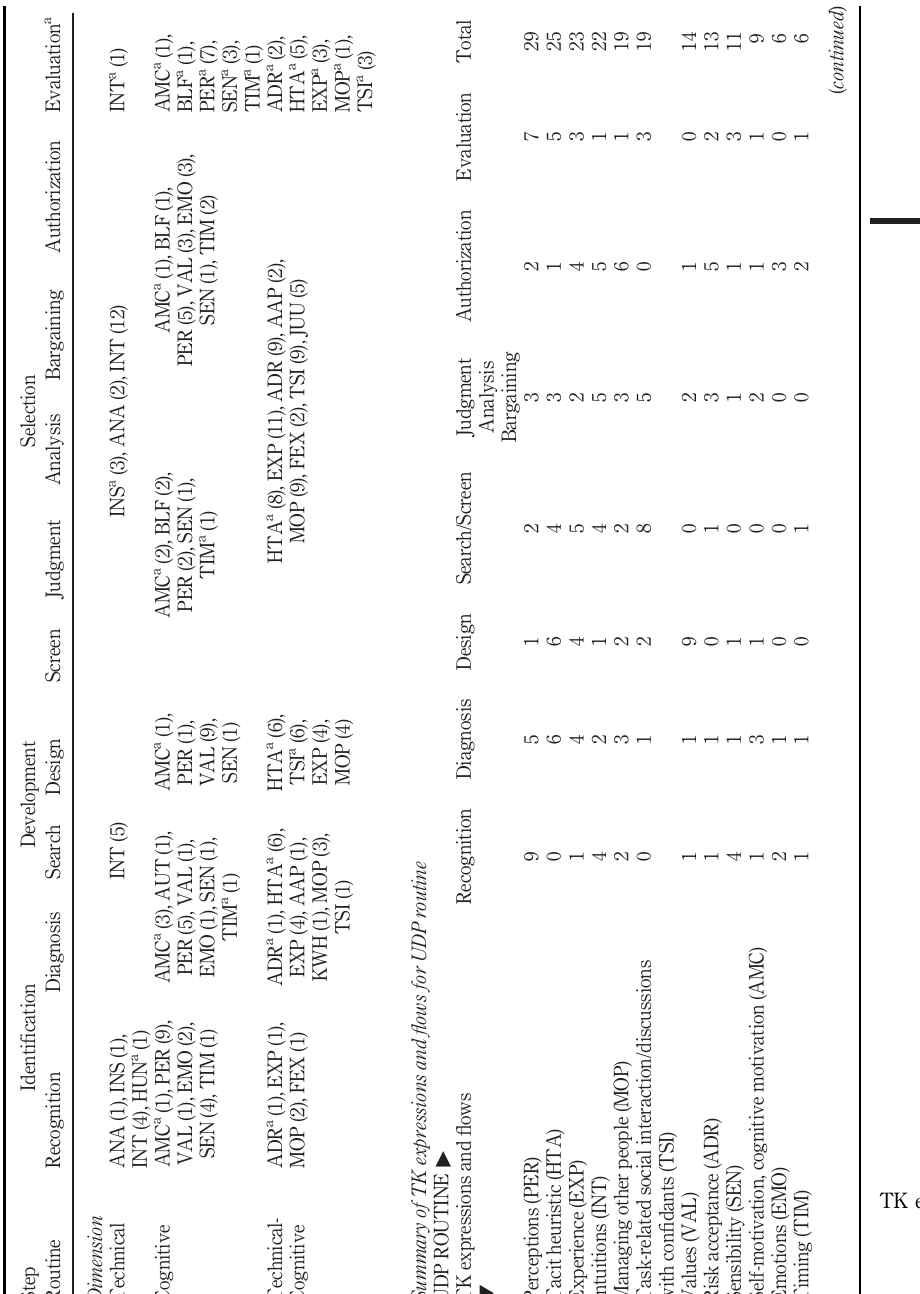
Table VI. TK expressions and flows for UDP routine and for